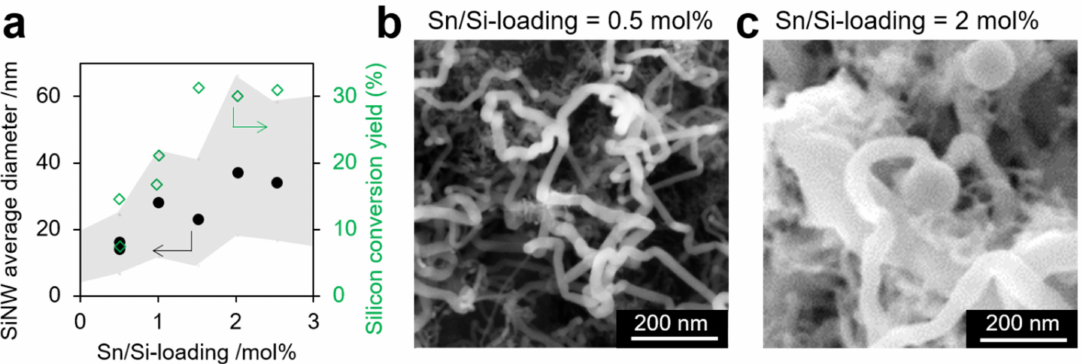
Figure 2. Effect of Sn/Si loading on SiNW growth in SiGt. ( a ) SiNW average diameters (dots) and Si conversion yield (diamonds) vs. Sn/Si loading. The grey area represents the 90% limit of SiNW diameters measured by SEM (>200 counts). ( b , c ) SEM images of SiNWs in SiGt produced with Sn/Si loading of 0.5 ( b ) and 2 mol% ( c ), respectively. SEM images and histograms for all samples are shown on Figure